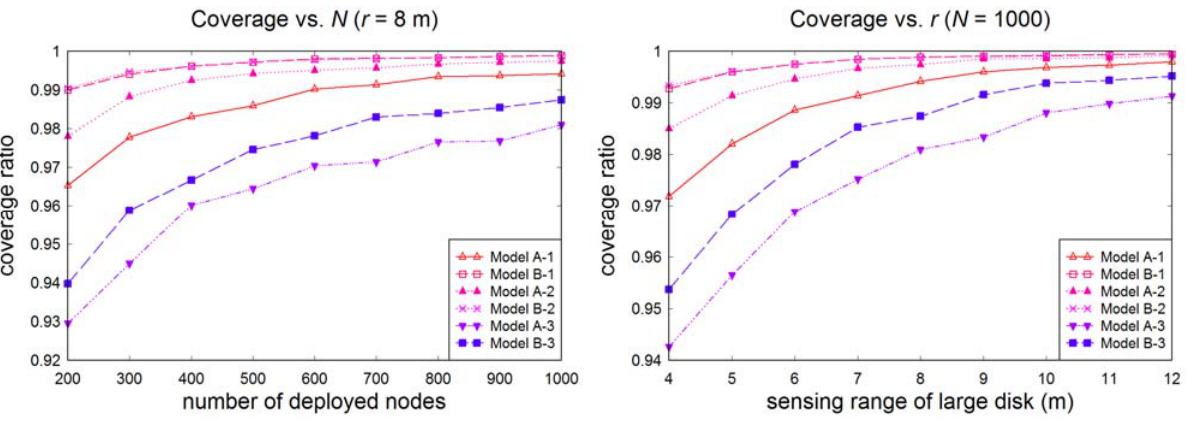
Figure 5. Coverage variations with different node density and sensing range.